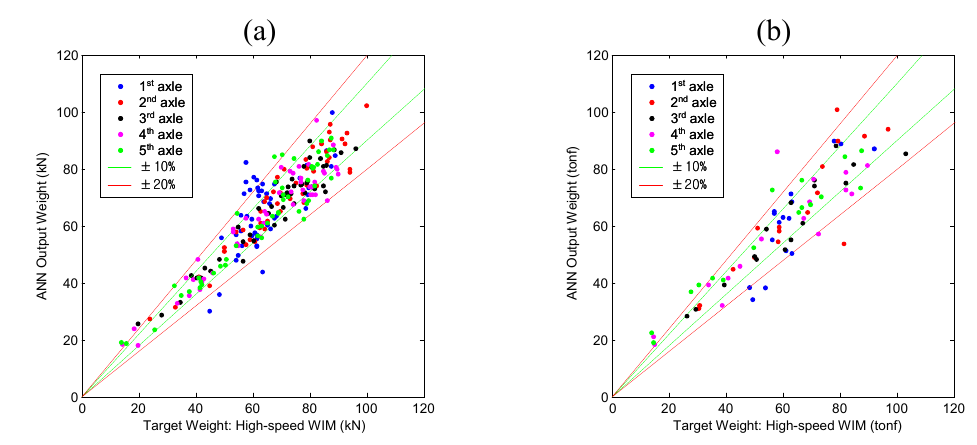
Figure 11. ANN construction for Geumdang Bridge (5-axle random trucks) (a) Results of training. (b) Results of validation test.